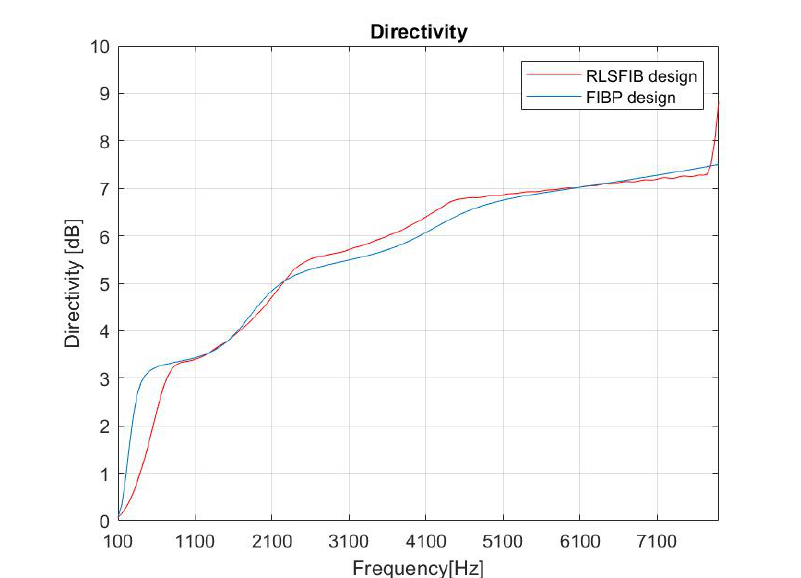
Figure 3. Directivity comparison: frequency-invariant beam pattern design (FIBP) blue, robust least-squares frequency-invariant beamformer design (RLSFIB) red.